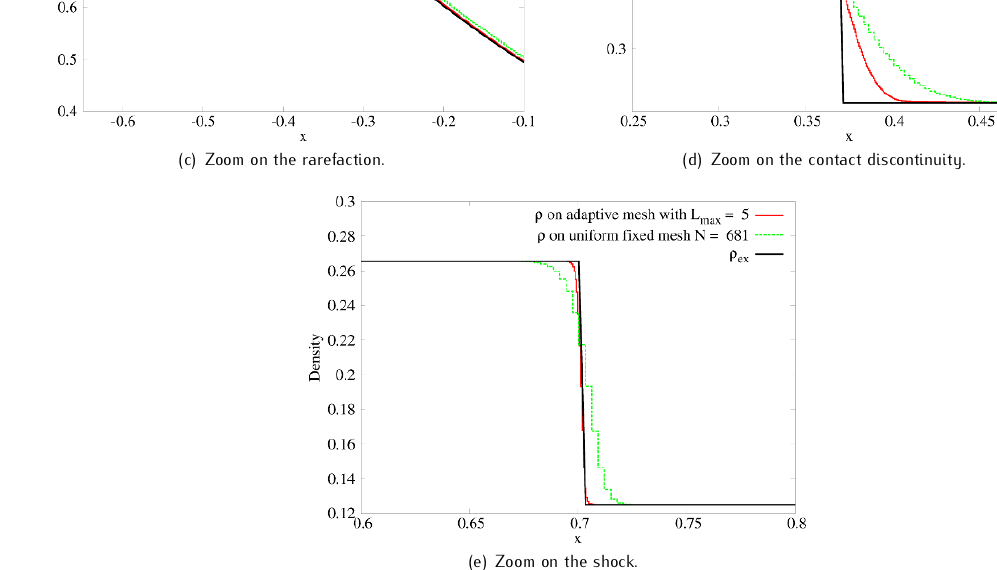
max = 5 and the AB1 scheme on